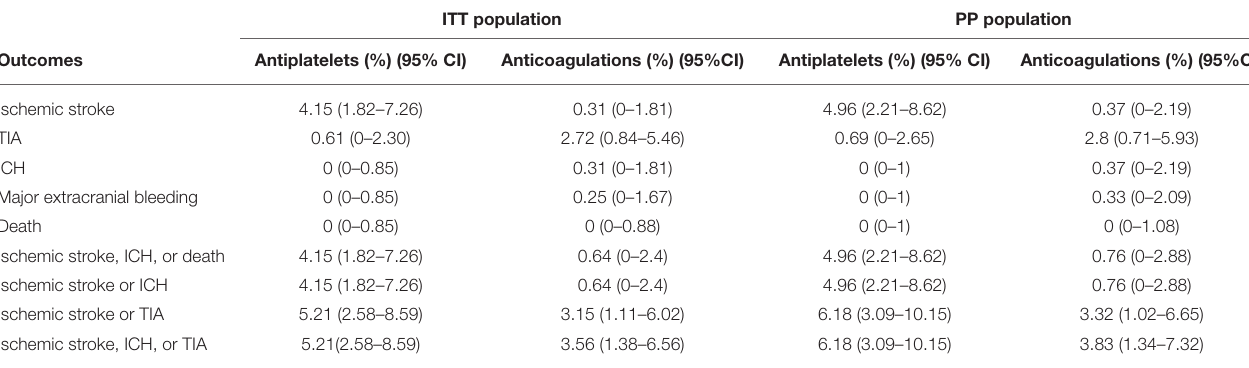
TABLE 2 | Summary of the meta-analysis of the outcomes within 3 months of the antiplatelet and anticoagulation therapies. ITT population